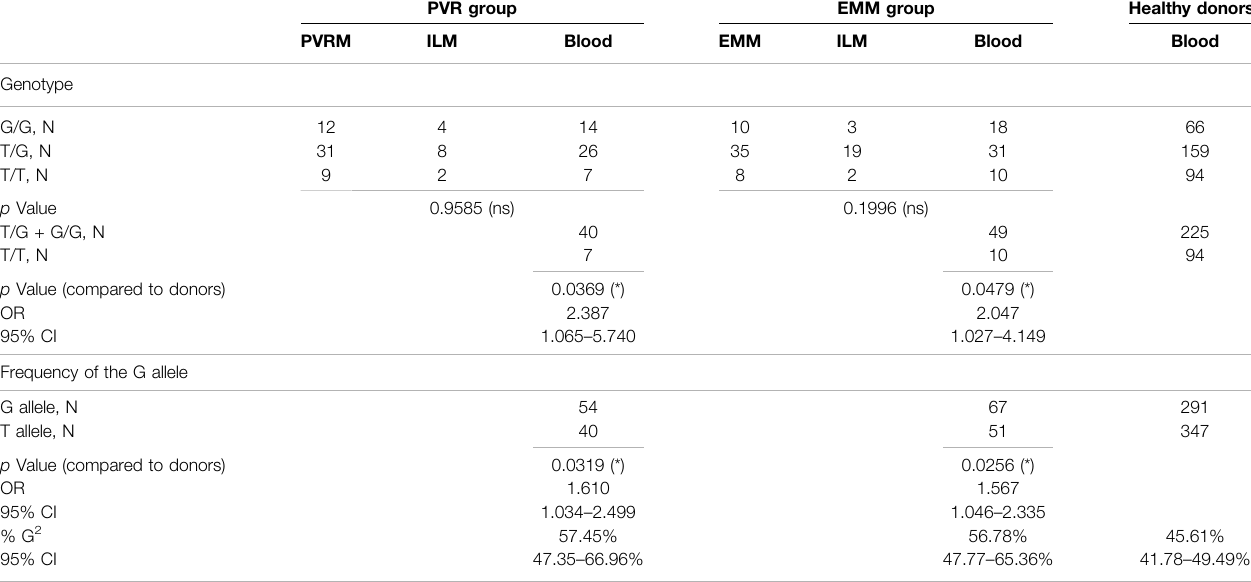
TABLE 2 | Genotype Distribution of MDM2 T309G and frequency of the MDM2 SNP309 G allele in all samples.